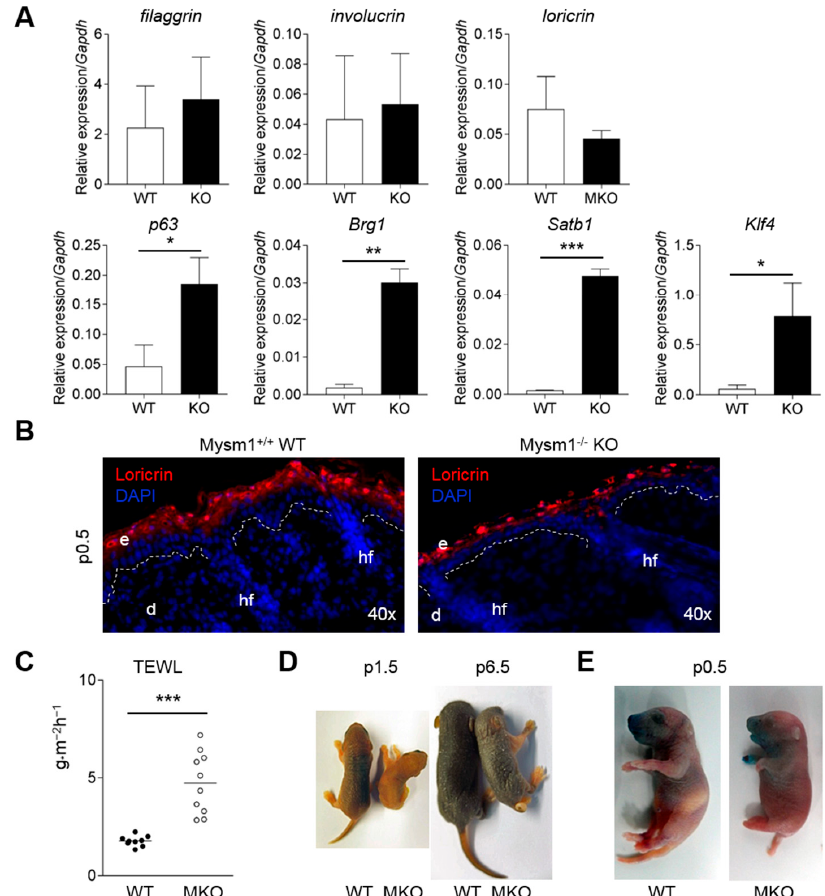
Figure 5. Functionally defective epidermal barrier in newborn Mysm1-deficient mice. ( A ) mRNA analyses of EDC genes in newborn ( upper panel ) and transcriptional regulators from 4-week-old mice ( lower panel ) derived epidermal samples relative to Gapdh by qPCR; ( B ) IF analysis of Loricrin (red) in skin of newborn WT or Mysm1 − / − mice ( n > 3, representative images, original magnification 40×); ( C ) Quantification of transepidermal water loss (TEWL) on dorsal skin of newborn Mysm1-deficient (MKO) and wild-type (WT) mice ( n > 3 per genotype, 2 independent measurements per mouse); ( D ) Skin wrinkling of postnatal MKO mice relative to WT controls; ( E ) Toluidine blue dye penetration assay performed with newborn (p1) MKO mice in comparison to WT littermates.